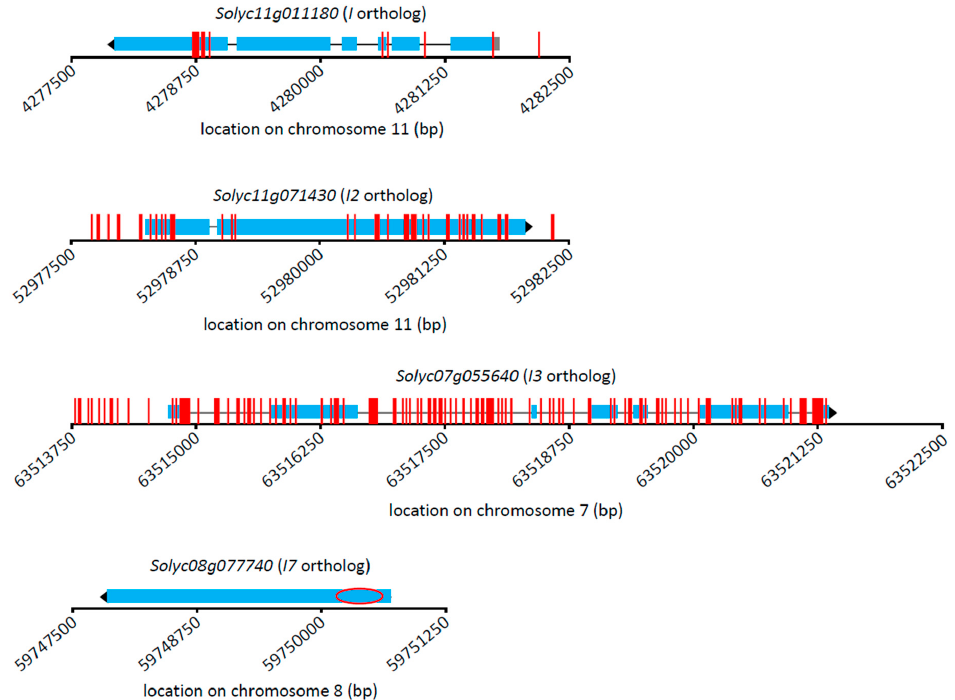
Figure 3. Single nucleotide polymorphism (SNP) sites across I gene orthologs in tomato ( S. lycopersicum ). Vertical red lines show locations of SNP sites. Ortholog gene models are shown at correct x axis positions for Heinz 1706 ( S. lycopersicum) reference (blue bar, exons; black line, introns; and gray bar, untranslated region). Ortholog gene names are given above the gene model. The red circle in Solyc08g077740 shows the location of a cleaved amplified polymorphic sequence marker previously designed for I7 . A table showing SNP information for I , I-2 , and I-3 can be found in Supplementary Table S1.